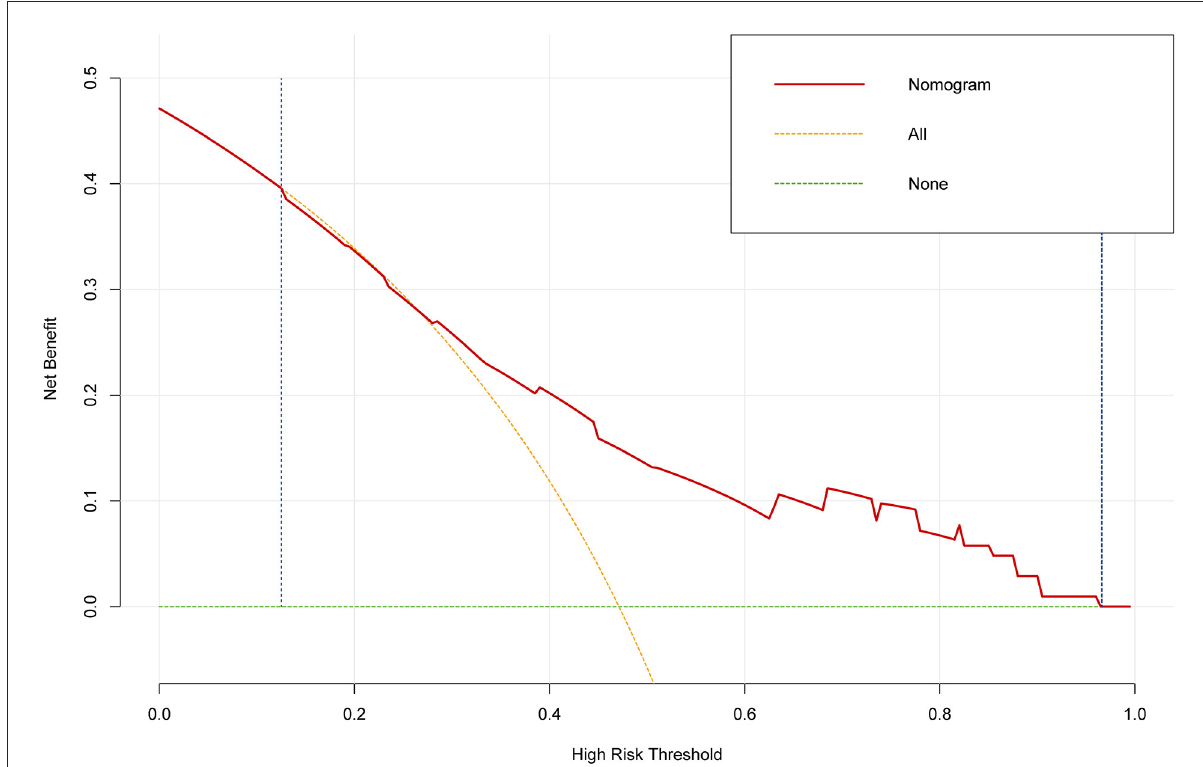
FIGURE6 The decision curve analysis (DCA) for the prediction model. The DCA showed that the nomogram could augment net benefits and exhibited a wide range of threshold probabilities in the EF